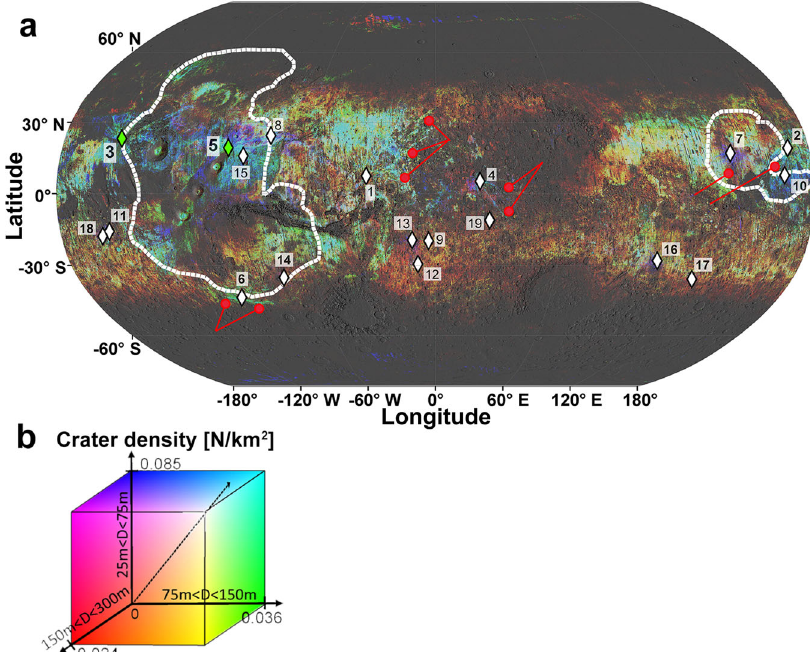
Fig. 1 Crater density map of Mars. a Density map of craters <300 m in diameter (89,054,458 entries), resolution 0.05°/px. Colours indicate crater densities of speci fi c diameter ranges (alternatively, supplementary Fig. 5 presents the crater density for each band separately). The diamonds identify 19 potential crater candidates (D > 3 km) for the launch of Martian meteorites (see Supplementary Table 2 for the size, location and model age of those craters), identi fi ed from radial patterns of secondary crater rays (D < 300 m). White dashed lines represent the contour of the Tharsis dome (at the left) and Elysium (at the right). Tooting (label 3) and 09-00015 (label 5) are highlighted in green and their rays of secondaries are shown on Fig.2a and b respectively. Red arrows point some secondary crater rays and readers are invited to visit http://craters.computation.org.au/ and http://HIVE.curtin. edu.au/research/CDA-94M-release for high-resolution versions of the map. Background: MOLA shaded relief (http://bit.ly/HRSC_MOLA_Blend_v0), projection: Robinson. b Legend of the crater density map shown on panel a. Each dimension of the colorcube corresponds to the crater density (number of craters per km 2 ) of speci fi c diameter ranges (blue: 25 – 75 m, green: 75 – 150 m and red: 150 – 300